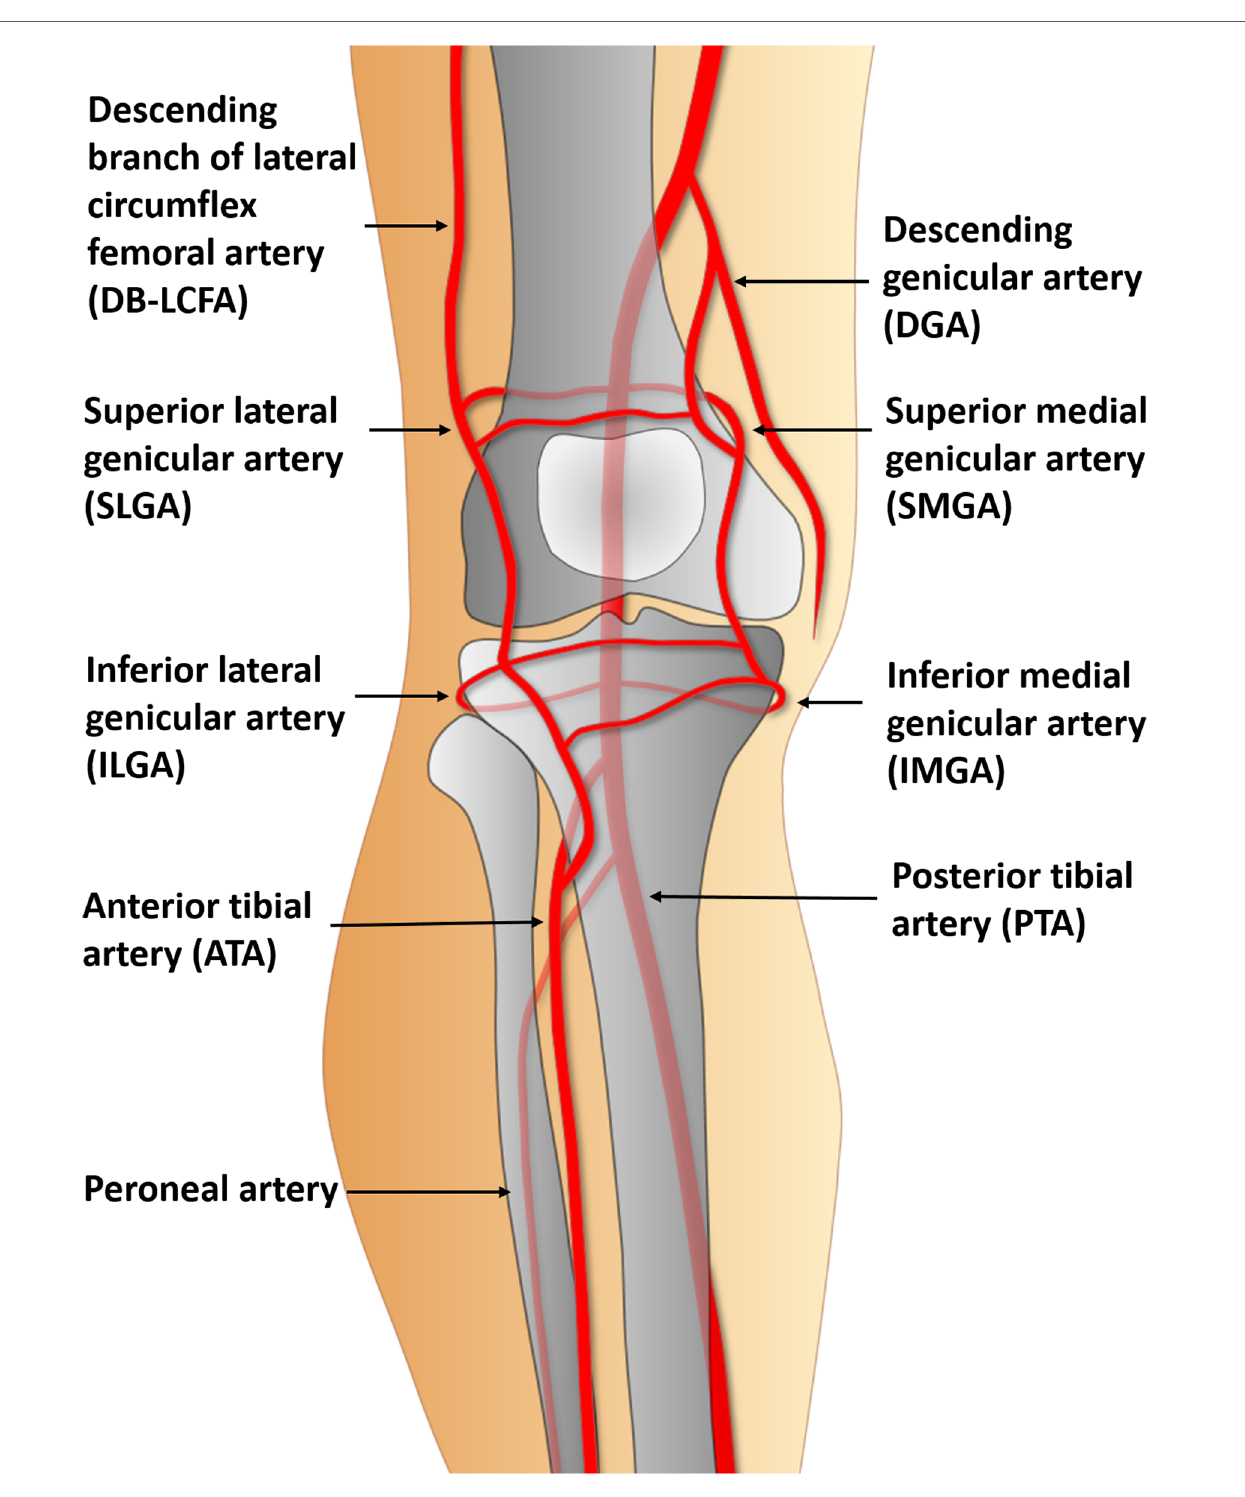
FIGURE 1 Potential recipient arteries in the knee region for free tissue